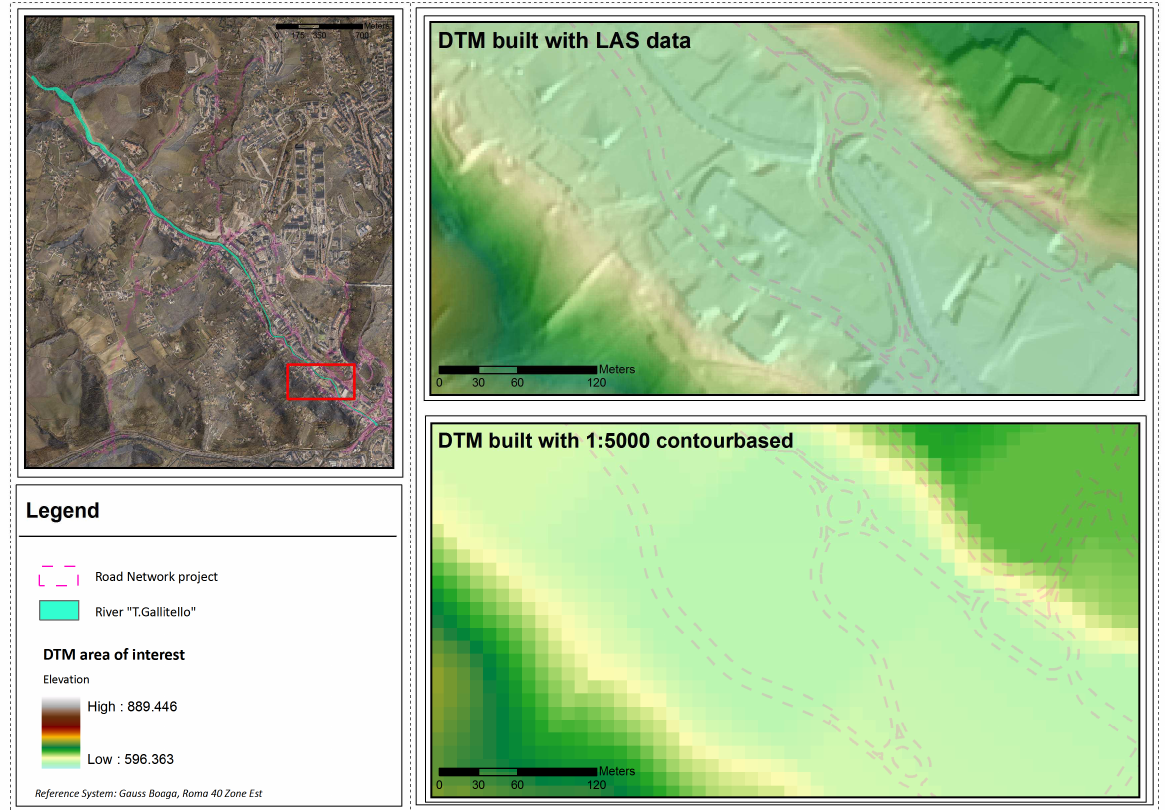
Figure 1. Comparison between the DTM realized from ALS data (top) and the DTM built with 1:5000 contour-based (bottom)